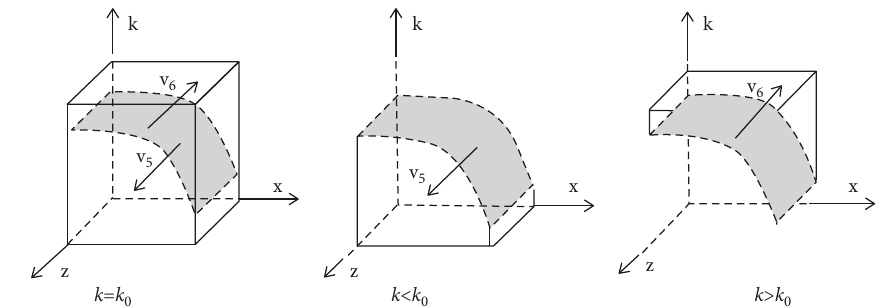
Figure 3: Replication dynamic phase diagram of